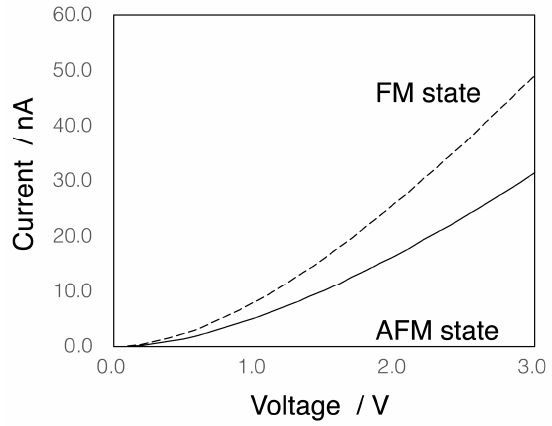
Figure 4. Calculated I–V characteristics. Solid and dashed lines represent 1 AFM and 1 FM , respectively. The applied voltage was assumed to be in the range from 0 to 3 V.